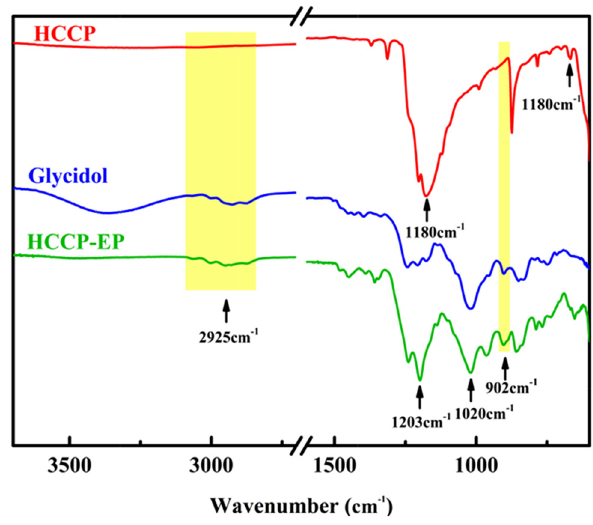
Figure 1: FT - IR spectra of HCCP, glycidol, and HCCP - EP.